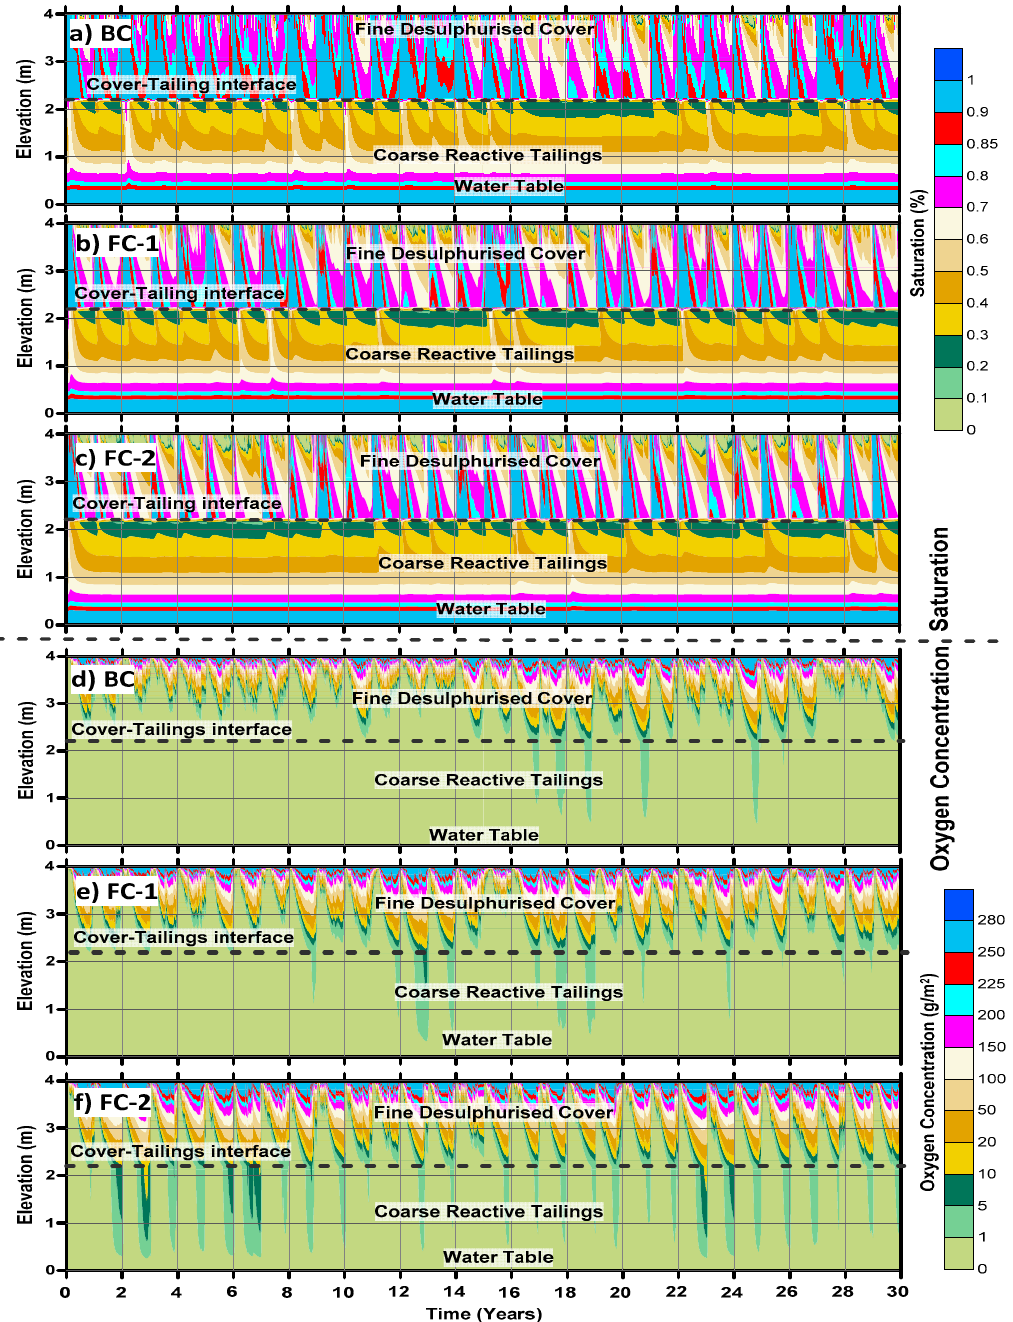
Figure 15. Comparison of 30-year time histories of saturation and oxygen concentration for the FC profile. Saturation for climates ( a ) BC, ( b ) FC-1, and ( c ) FC-2; and oxygen concentration for climates ( d ) BC, ( e ) FC-1 and ( f ) FC-2.